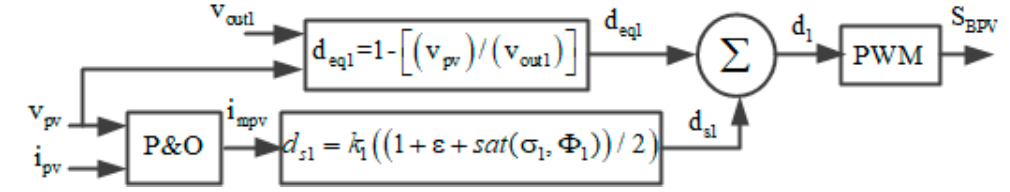
Figure 8. Enhanced the P&O technique having a sliding mode approach.